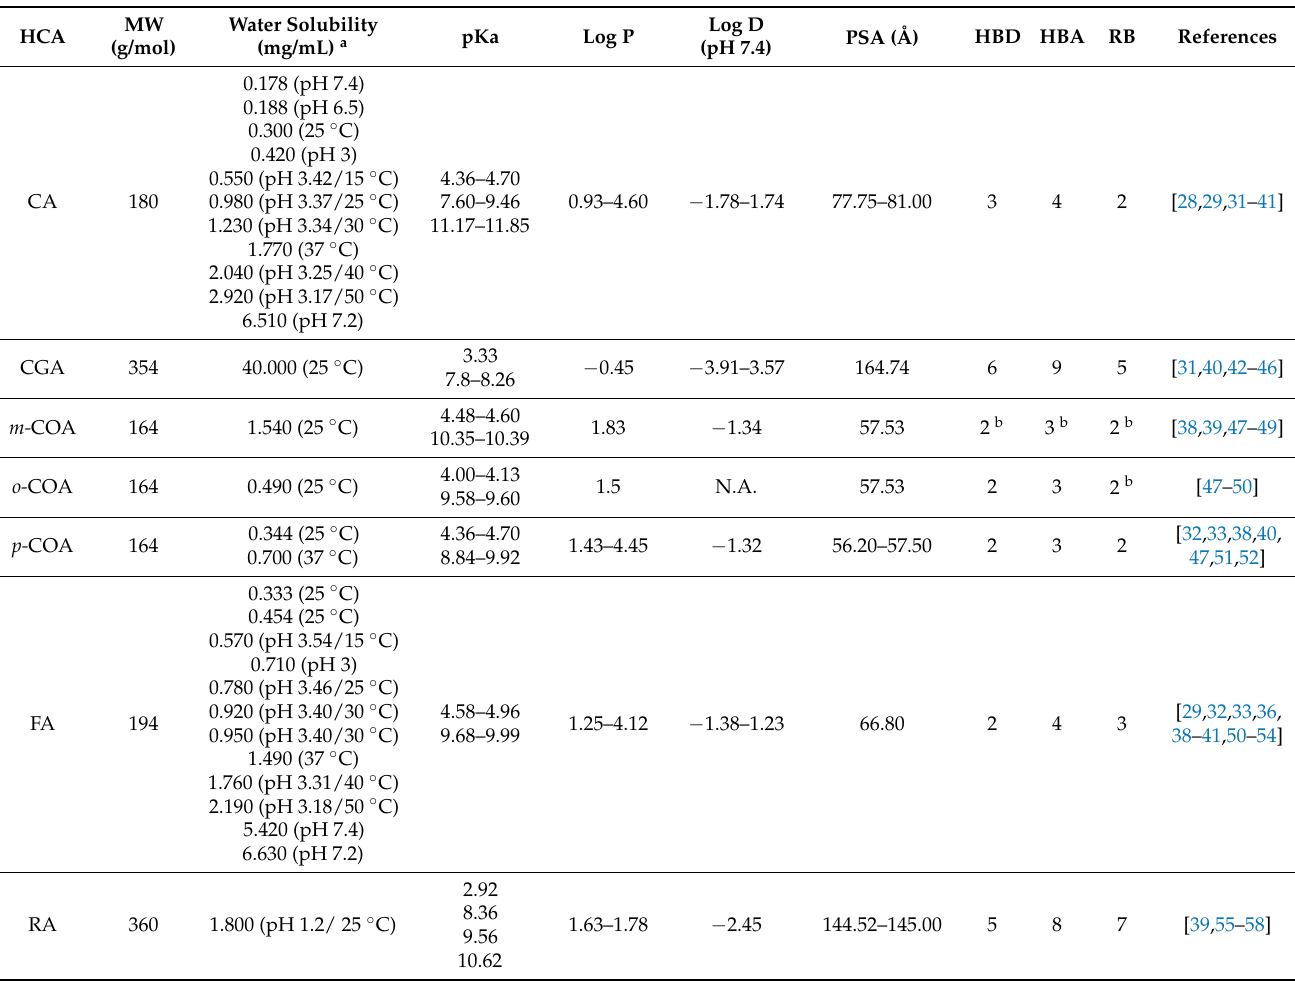
Table 1. Physicochemical properties of